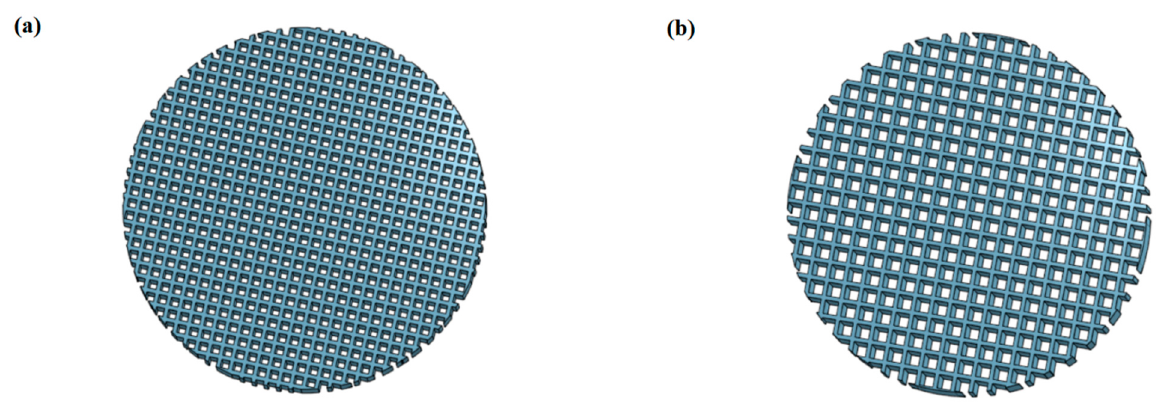
Figure 1. ( a ) 3D representation of the 300-micron pore size test sample; ( b ) 3D representation of the 500-micron pore size test sample.